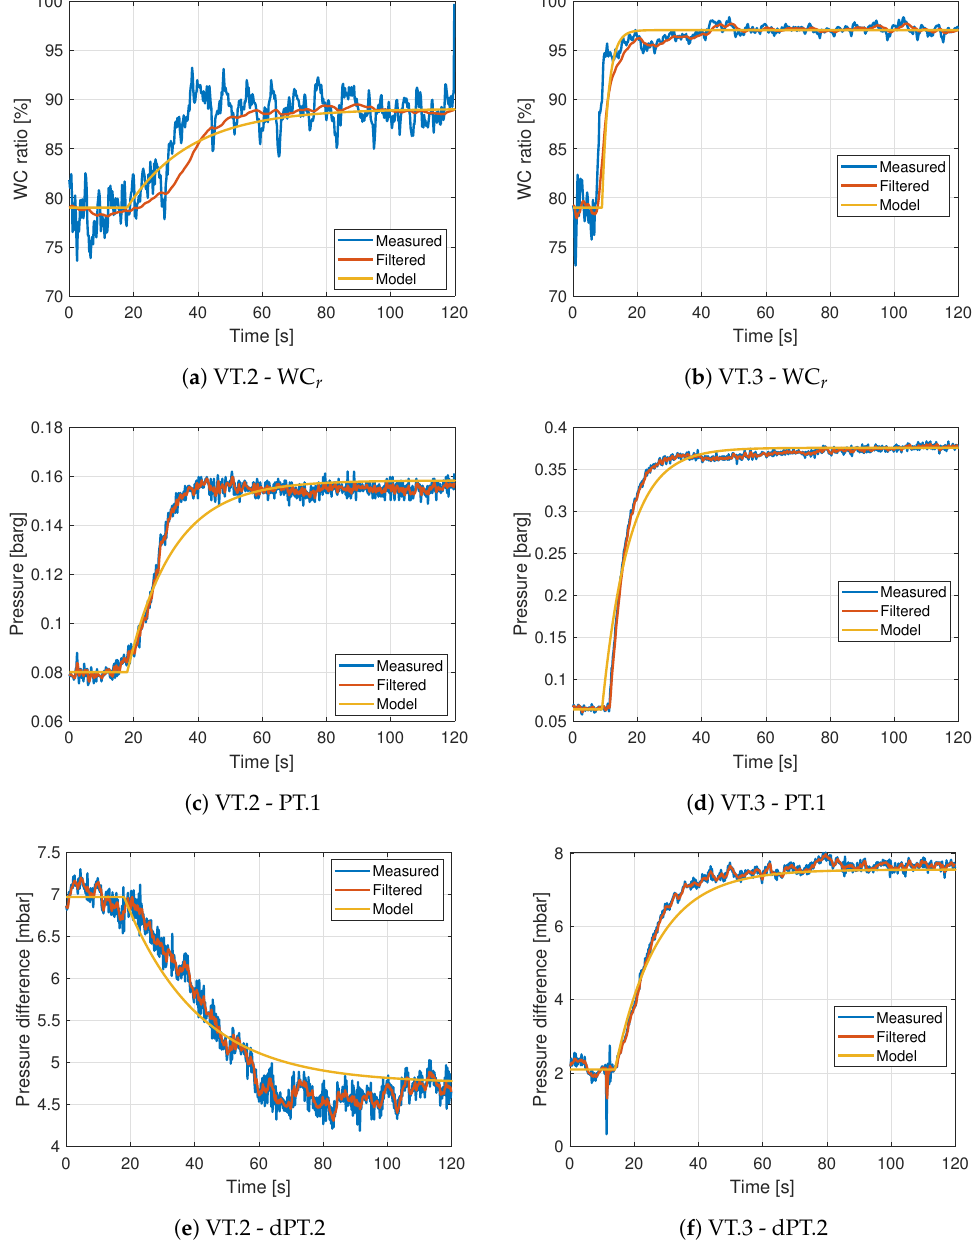
Figure 4. Step response comparison between measured signal, filtered signal and transfer